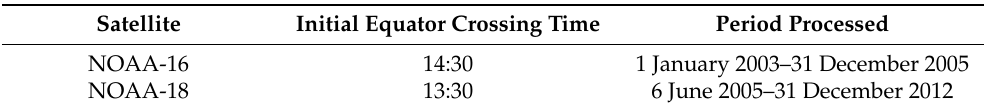
Table 9. Temporal coverage and satellites that are included in this AVHRR aerosol demonstration